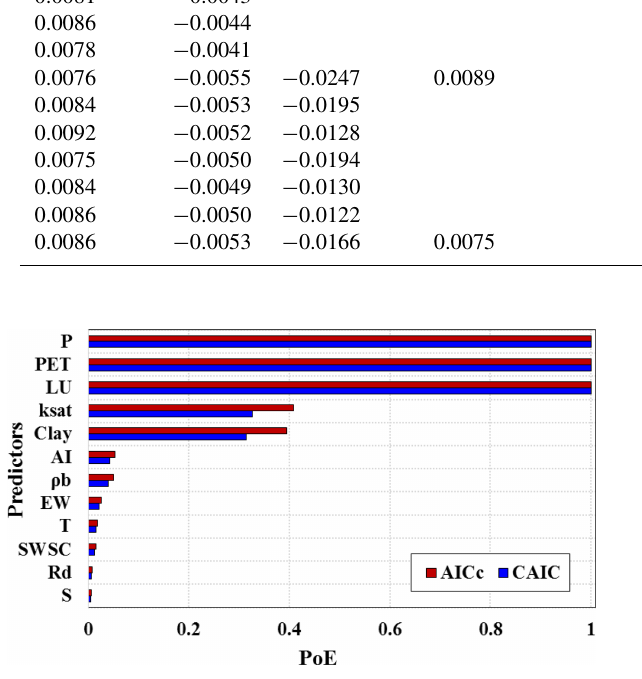
Figure 4. Proportion of evidence according to AIC c and CAIC for 12 predictors (sorted in descending order of